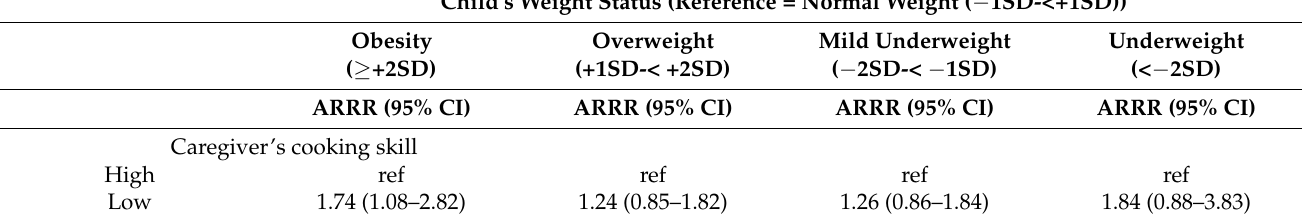
Table 4. Adjusted relative risk ratios of child obese, overweight, mild-underweight, and underweight status according to levels of caregiver cooking skills ( n =